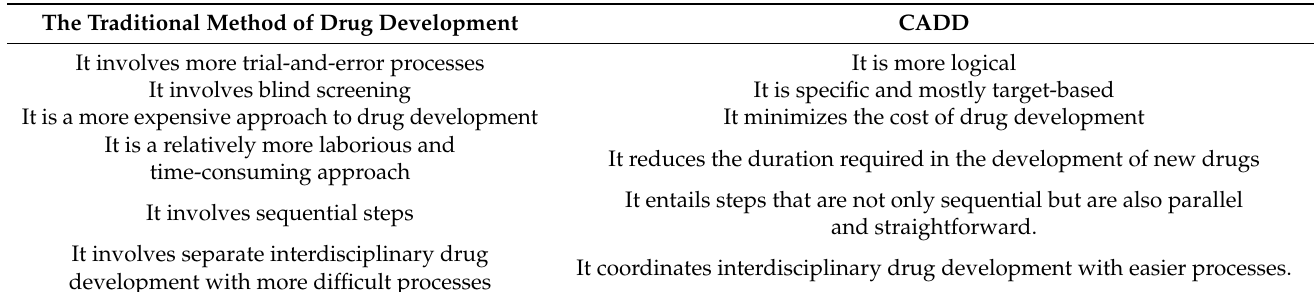
Table 1. Comparison of the traditional method of drug development with CADD (computer-aided drug design). The Traditional Method of Drug Development